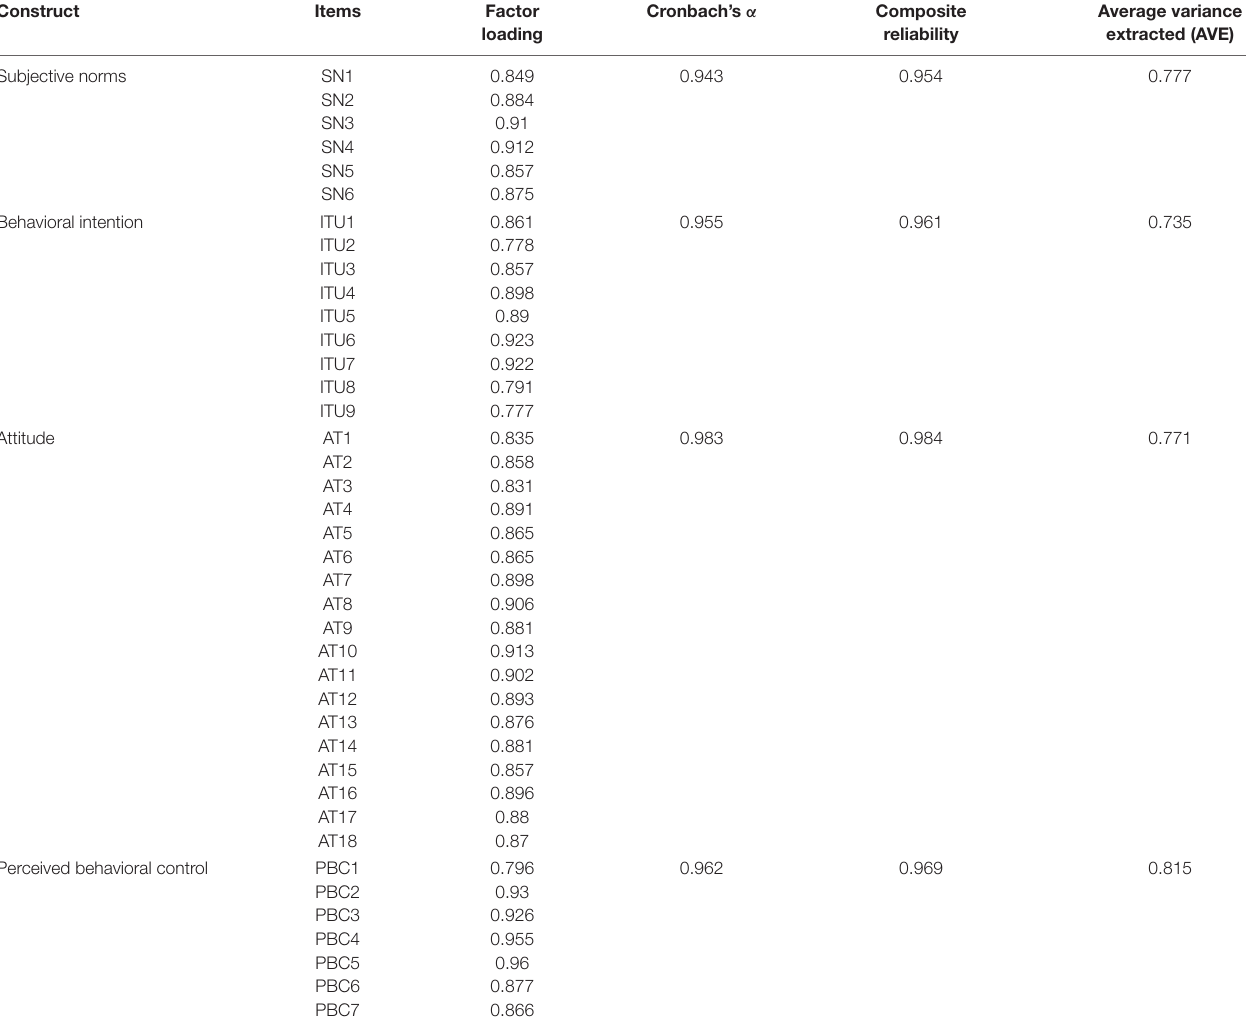
TABLE 1 | Factor loading, Cronbach’s α , composite reliability, and average variance